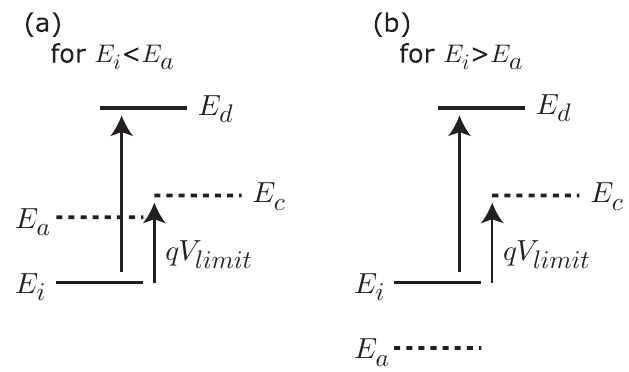
FIG. 3. Modulated particle energy by an induction-voltage modulator in case of V (cid:2) V (b) for E > E